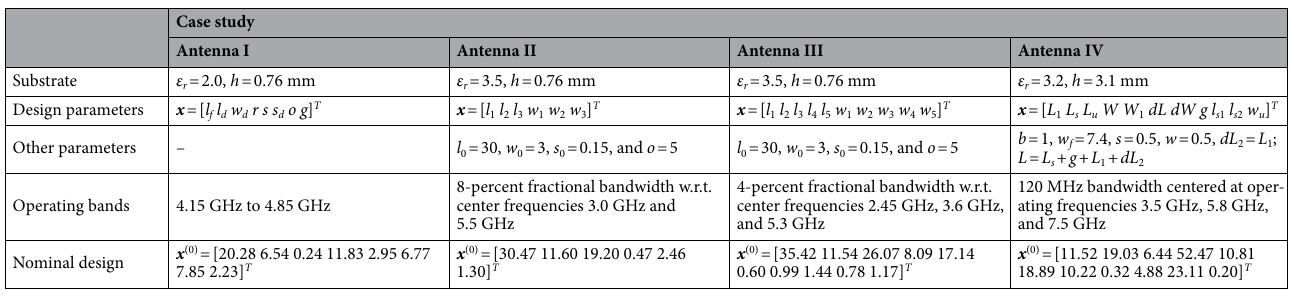
Table 2. Verification case